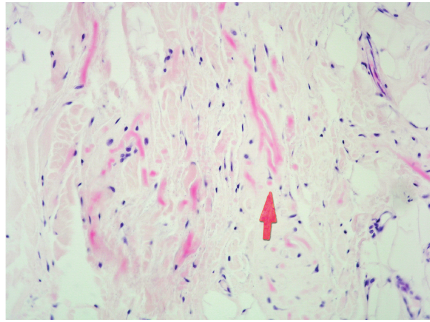
Figure 4: H&E stain showing branched and unbranched coarse elastin fibres admixed with collagen and mature adipose tissue (Ar- row pointing at coarse branched elastin fibre).